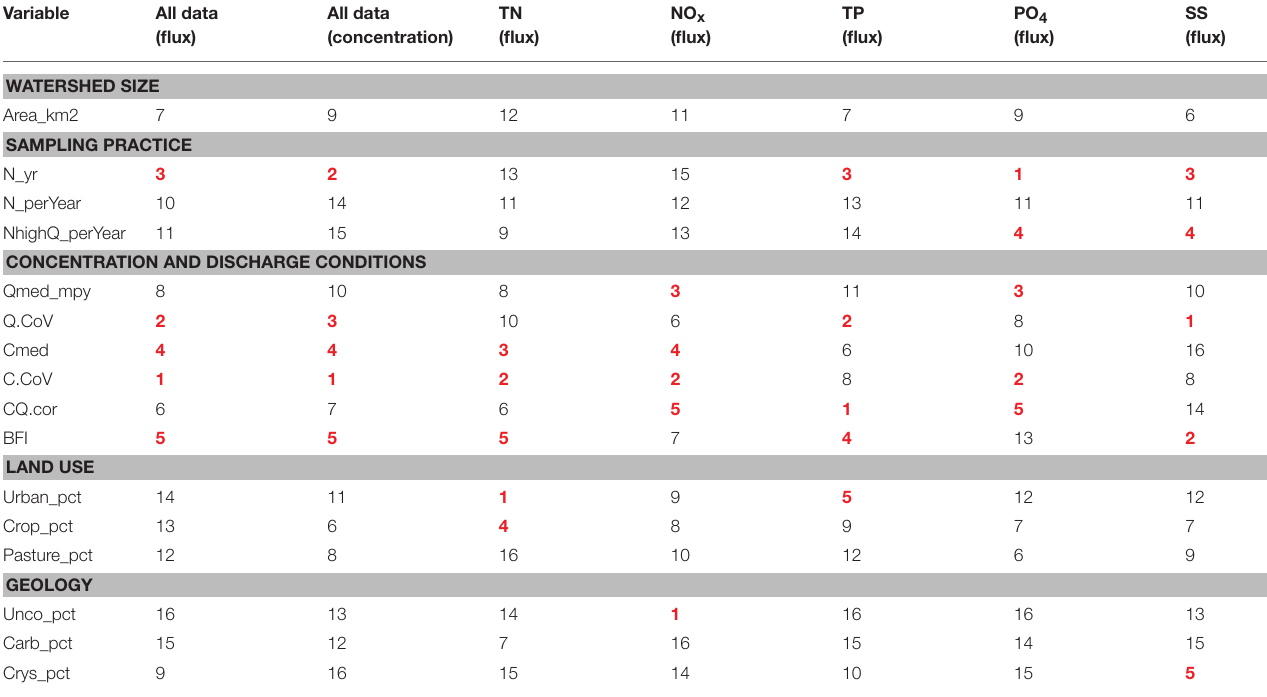
TABLE 2 | Numeric ranking of explanatory variables’ importance for flux bias of all constituents, concentration bias of all constituents, and flux bias of each individual constituent.